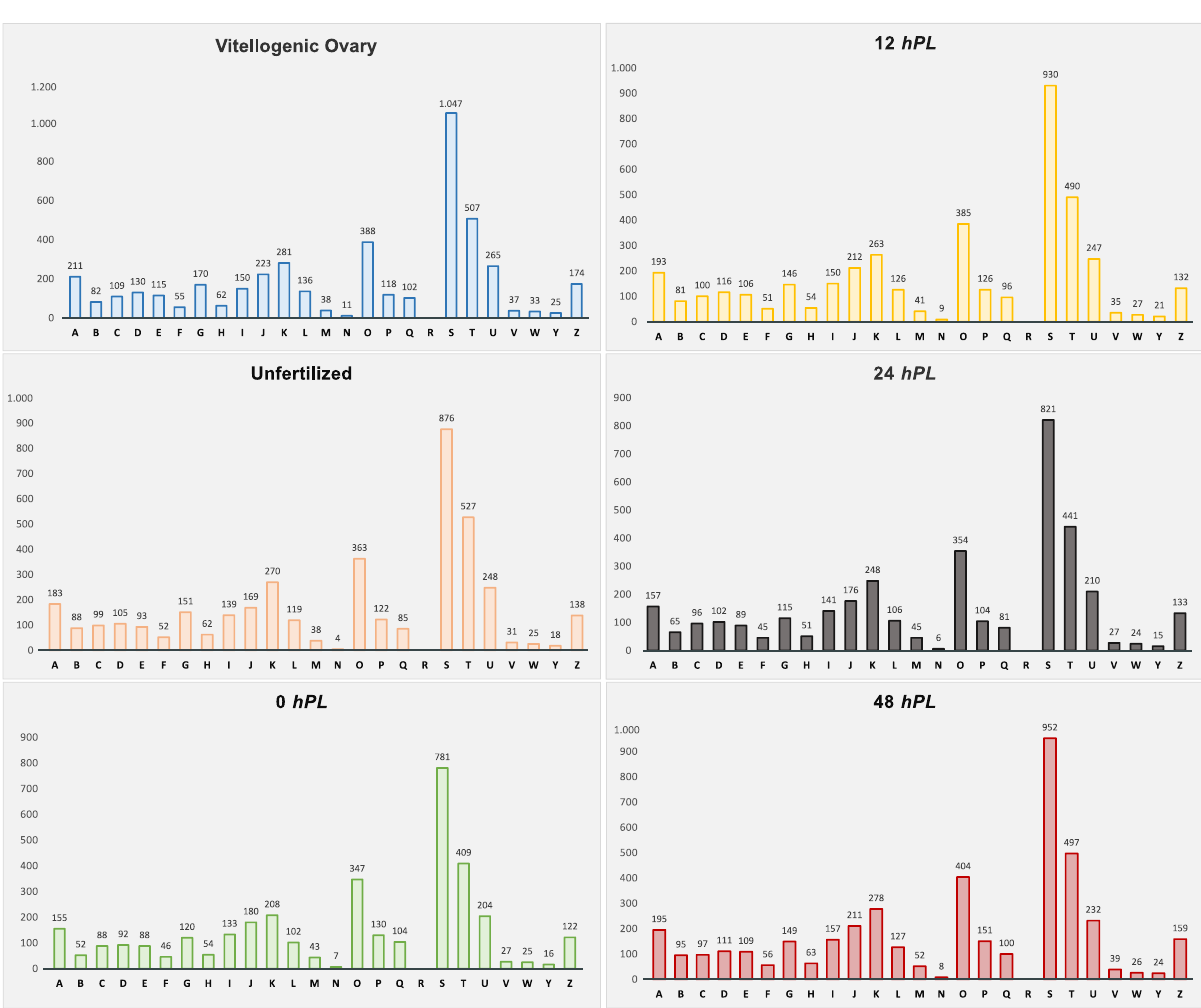
Figure 1. Classification of eggNOG annotations in the R. prolixus transcriptomes. The capital letters on the X-axis represent different eggNOG categories. Y-axis shows the number of transcripts in each